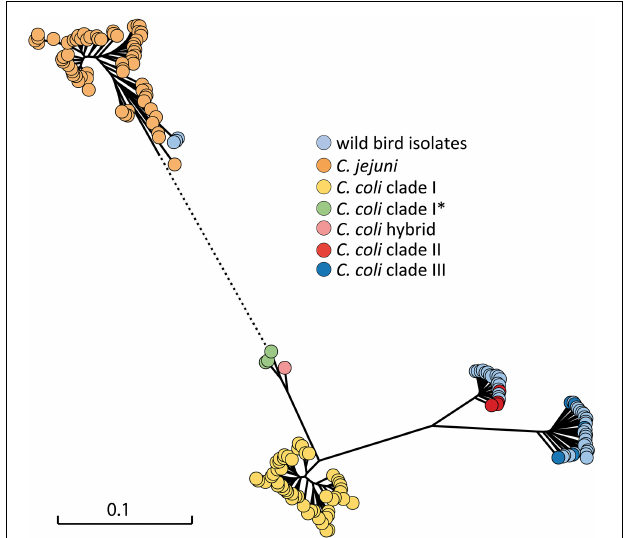
FIGURE 2 | Maximum likelihood phylogenetic tree of 42 thermophilic Campylobacter spp. isolates from wild birds in the context of C. jejuni and C. coli complete genomes from NCBI ( Supplementary Table 2 ) constructed on the basis of the core genome. The scale bar represents the distance between the sequences determined by the number of SNP differences in core genes. Dotted line indicates shortened distance to C. jejuni cluster, which is out of scale. *,